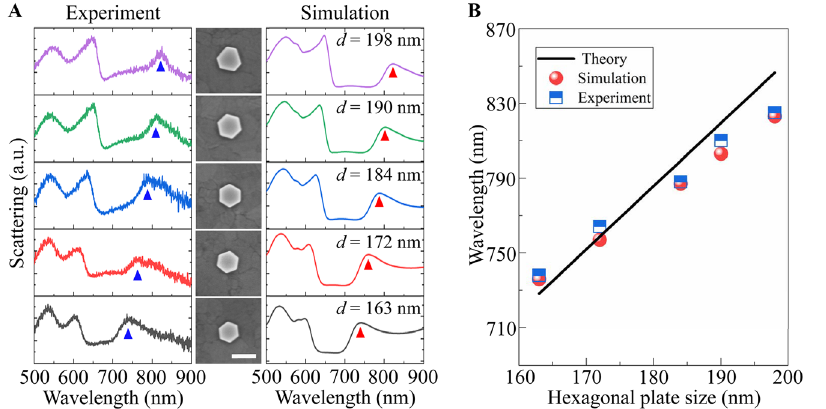
Figure 5: (A) Scatteringspectra of hexagonal Au NPoMforthe nanoplatesize changingfrom 163 – 198 nm.The left and rightcolumnsshow the experiment and simulation results. The triangle dots follow the spectral position of the RBM. The middle column displays the SEM images of thehexagonalAunanoplate,wherethescalebaris200nm.(B)ResonancewavelengthofRBMversusnanoplatesize.Thebluesquaredotsand redcircledotsarefortheresultsextractedfromexperimentandsimulationspectrain(A).Theblacklinerepresentsthedispersionpredictedby the Fabry – Pérot